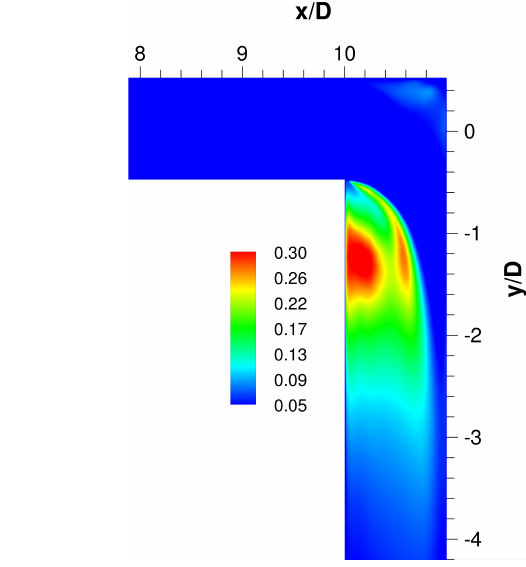
of the 90 ◦ case in the x – y b